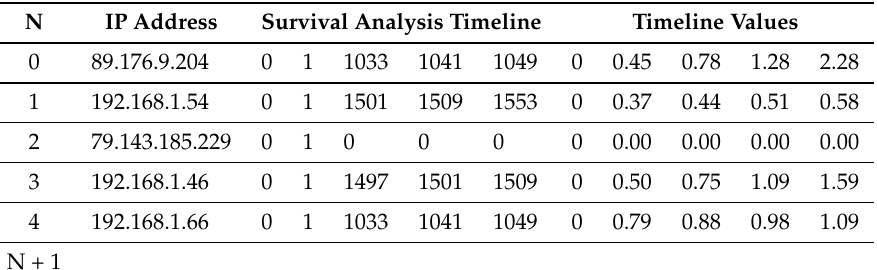
Table 6. Program output of the custom dataset.